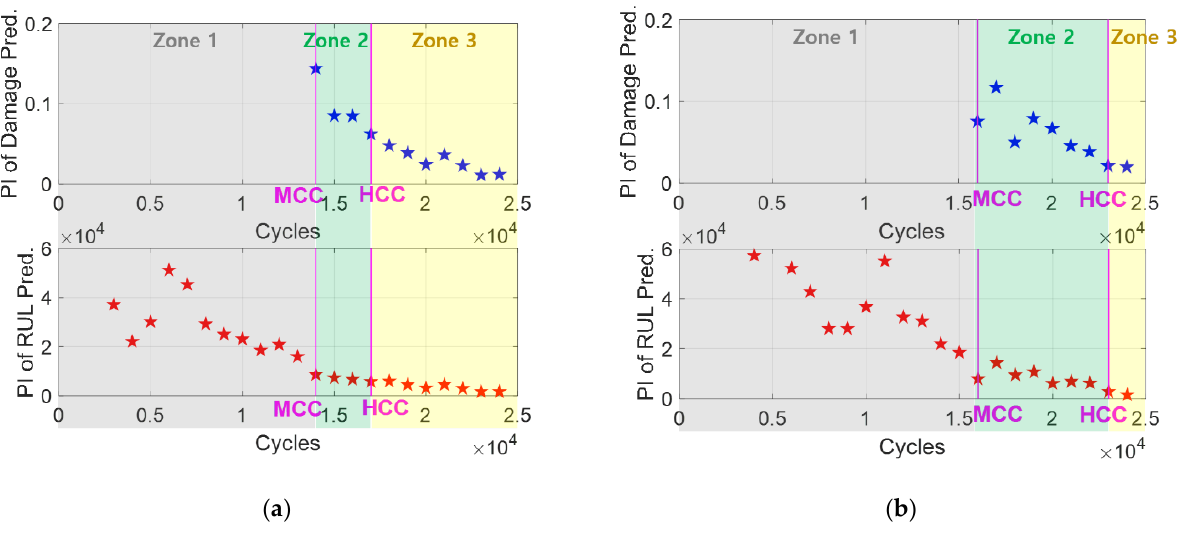
Figure 7. PIs and credibility criteria results: crack growth problem. ( a ) Medium level of noise, ( b ) large level of noise.